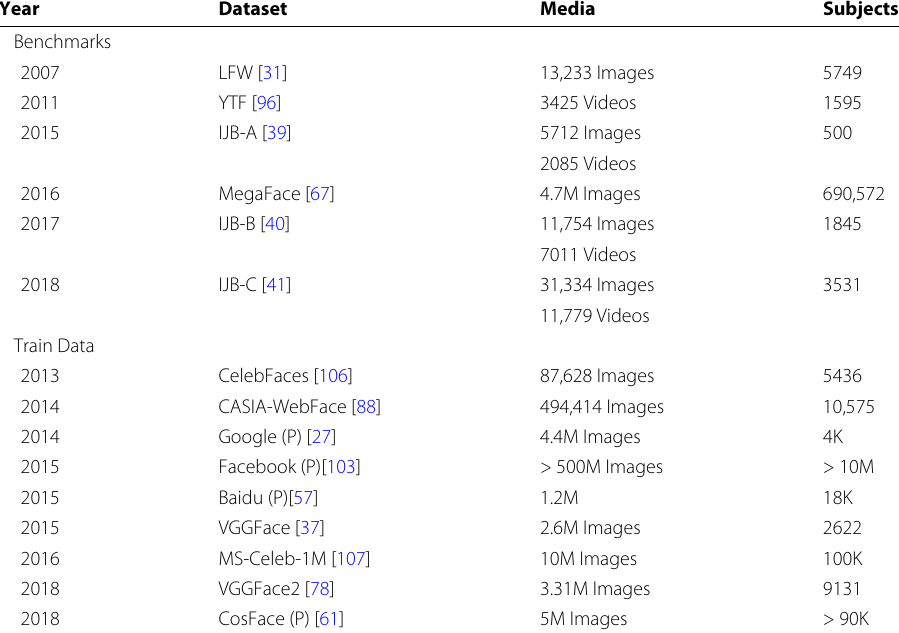
Table 3 The benchmark datasets and train datasets for face